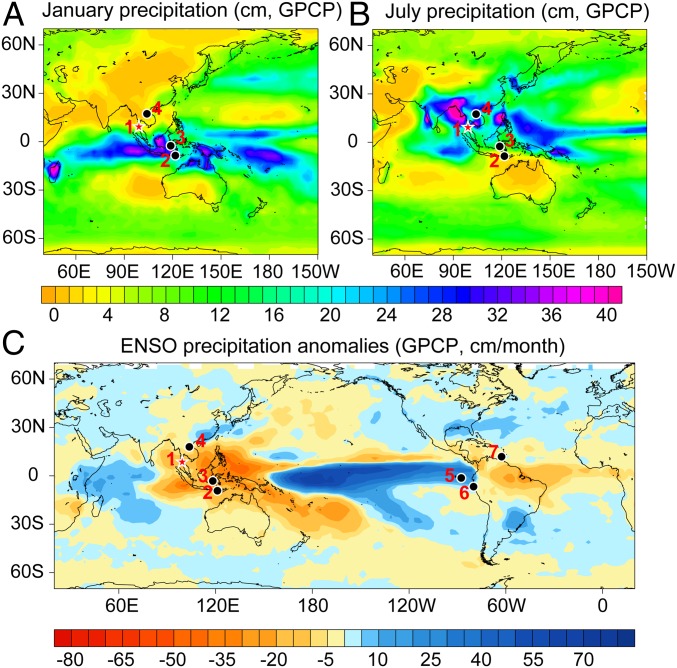
Hydroclimatic maps showing the location of Klang Cave and other paleoclimate sites. A and B display the global mean precipitation in January and July, respectively, in Indo-Pacific between 1988 AD and 2004 AD. Bands of heavy precipitation in the tropics indicate the ITCZ. (C) Map of monthly precipitation anomalies (millimeters per month) during the El Niño years of 1979–2006 AD (data source: http://research.jisao.washington.edu/data/gpcp/). The red star denotes the location of Klang Cave, and black dots mark the paleoclimate sites discussed in the text: 1, Klang Cave; 2, ref. 3; 3, ref. 39; 4, ref. 44; 5, ref. 40; 6, ref. 46; and 7, ref. 15.